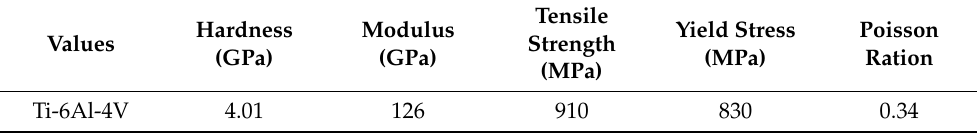
Table 2. Mechanical properties of Ti-6Al-4V